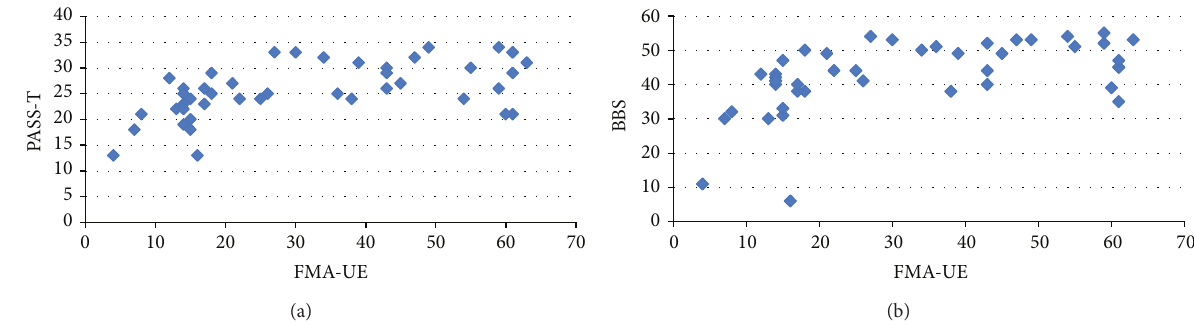
Figure 1: (a) Showing the relation between the total score of Fugl-Meyer Assessment: upper extremity (FMA-UE) and Postural Assessment Scale for Stroke (PASS-T). (b) Showing the relation between the total score of Fugl-Meyer Assessment: upper extremity (FMA-UE) and total score of Berg Balance Scale (BBS).